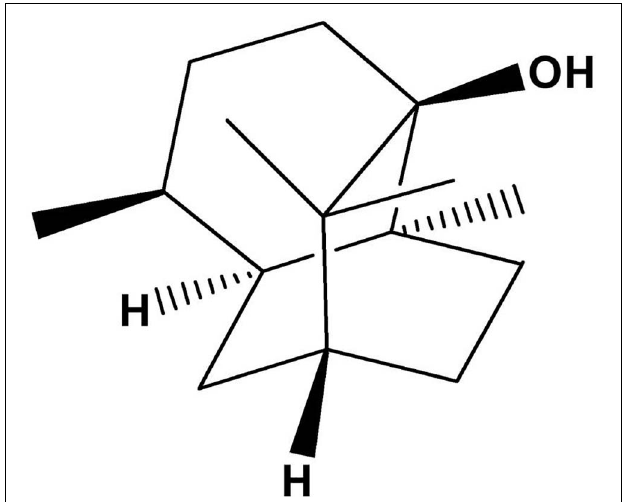
FIGURE 1 | Chemical structure of